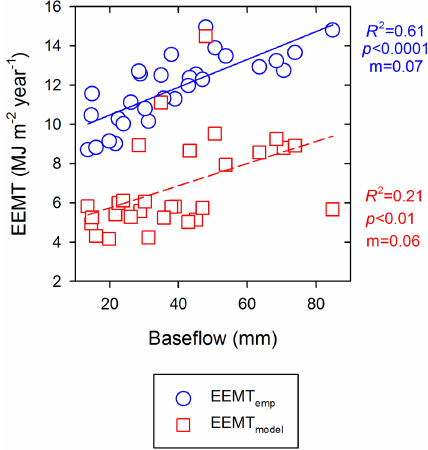
flow and EEMT showed a positive linear correlation. As water avail- ability in the JRB decreases, indicated by baseflow, EEMT also de-